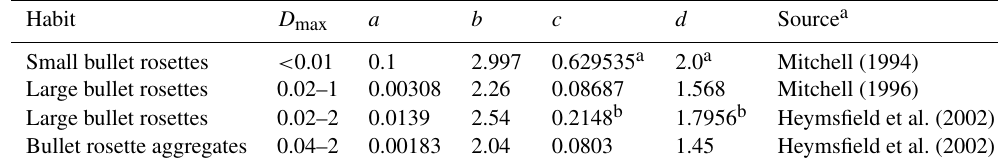
Table 1. Mass–dimensional and area–dimensional power law coefficients for m = aD b max and A = cD d max in cgs units.